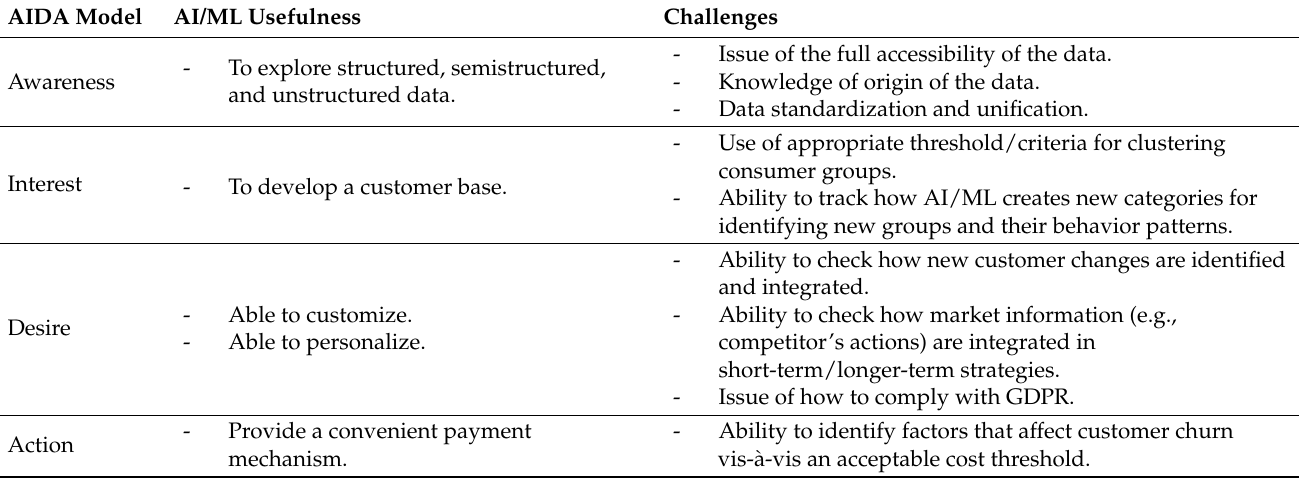
Table 3. Usefulness and challenges in relation to deploying AI/ML through the AIDA